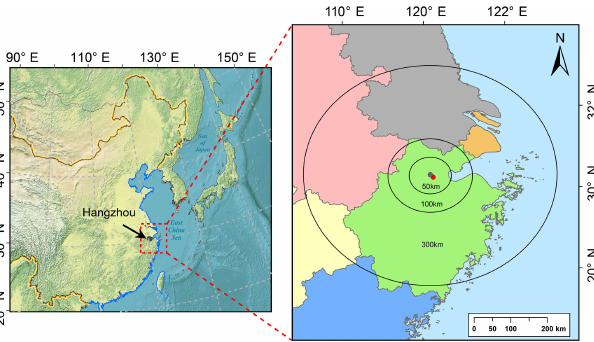
Figure 1. Geographic locations of Zhejiang (green), Shanghai (blue), Jiangsu (brown), Anhui (pink), Jiangxi (purple), and Fujian (gray). The red dot in the right panel represents the main venue for the Hangzhou G20 summit, and the gray dot denotes the location of the observational site for this study. By taking the main venue as the center of the emission control zone, the following three regions were set up with respect to different control intensities: the core emission control zone ( r < 50km), the strict emission control zone ( r < 100km), and the general emission control zone ( r <